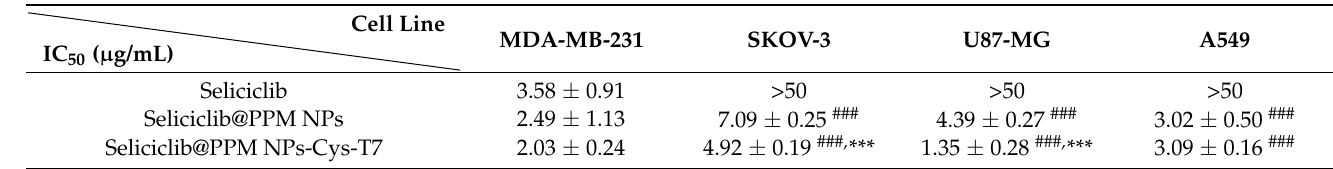
Table 2. The IC 50 of seliciclib, seliciclib@PPM NPs and seliciclib@PPM NPs-Cys-T7 in four cancer cell lines for 48-h treatment. (n = 3, mean ± SD, ### p < 0.001, compared to IC 50 of seliciclib; *** p < 0.001, compared to IC 50 of seliciclib@PPM NPs).